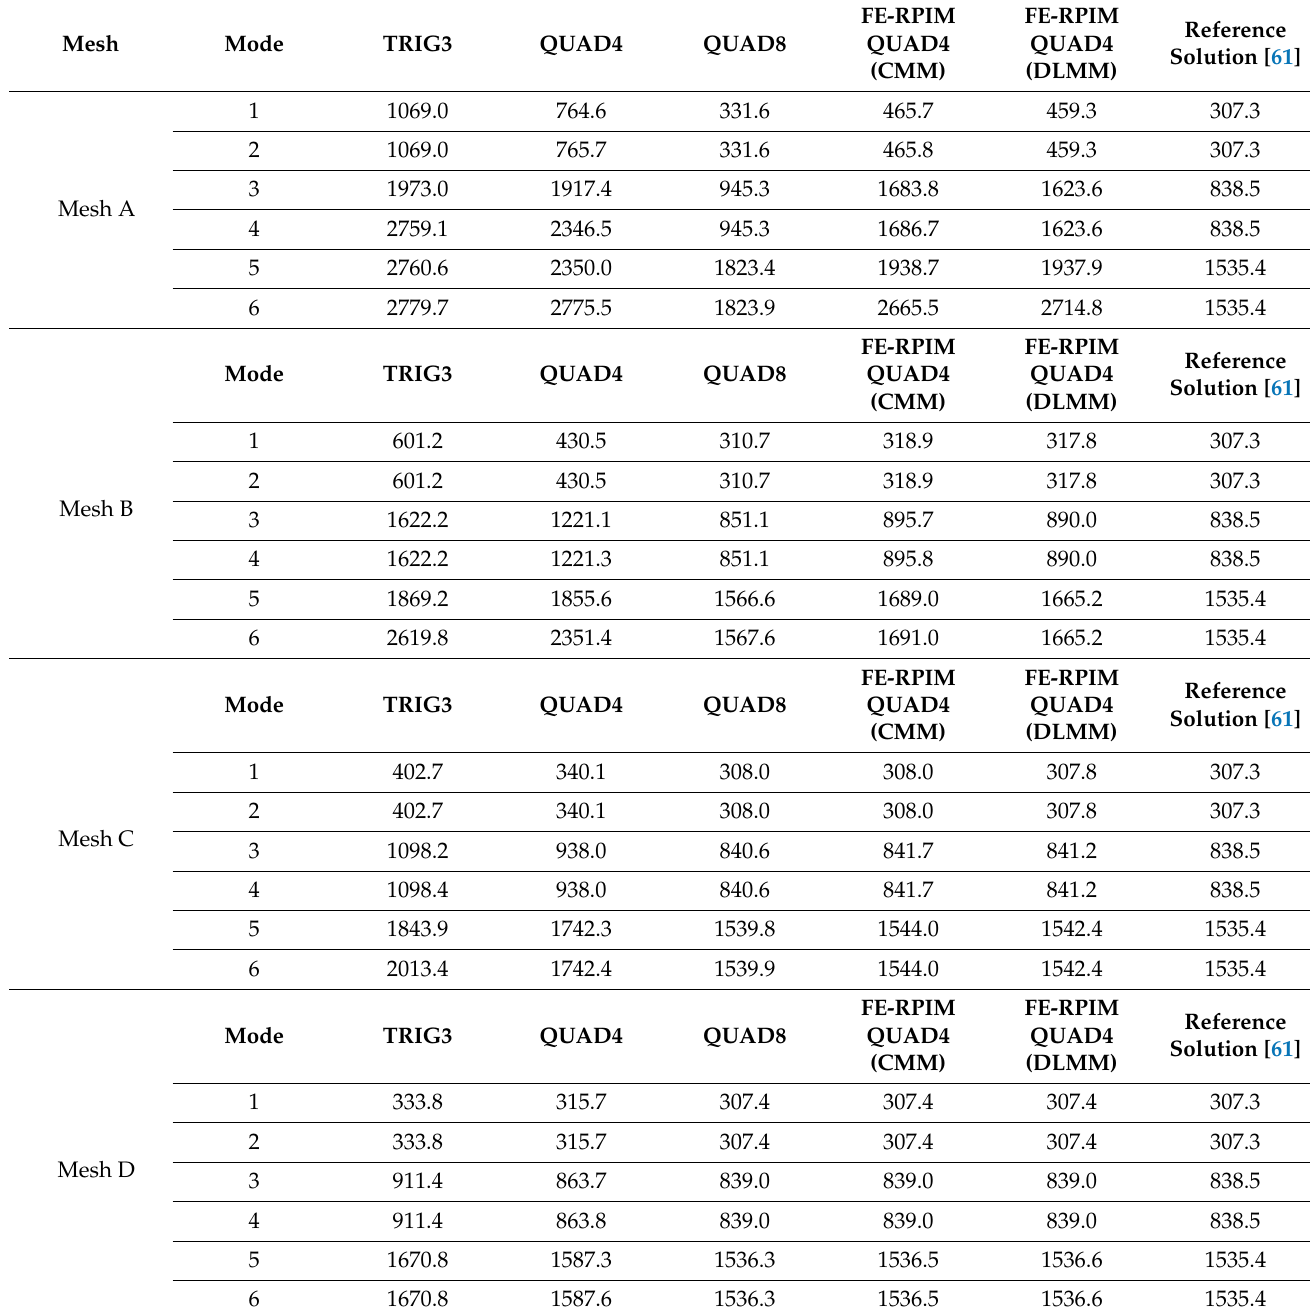
Table 2. Comparisons of computed frequencies (Hz) for the